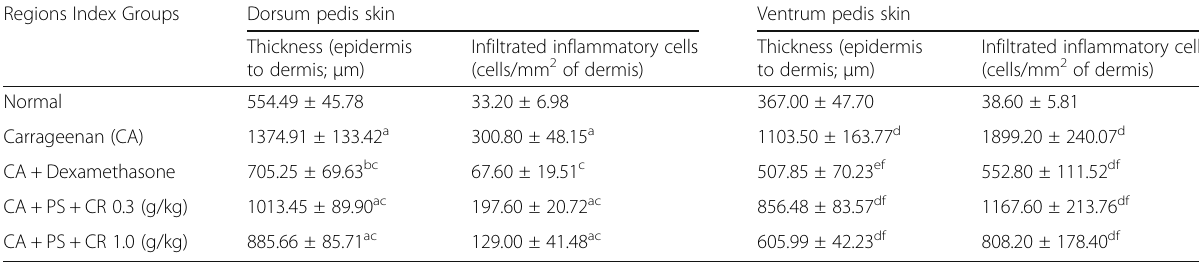
Table 1 Changes on the histomorphometrical analysis of hind paw skins Regions Index